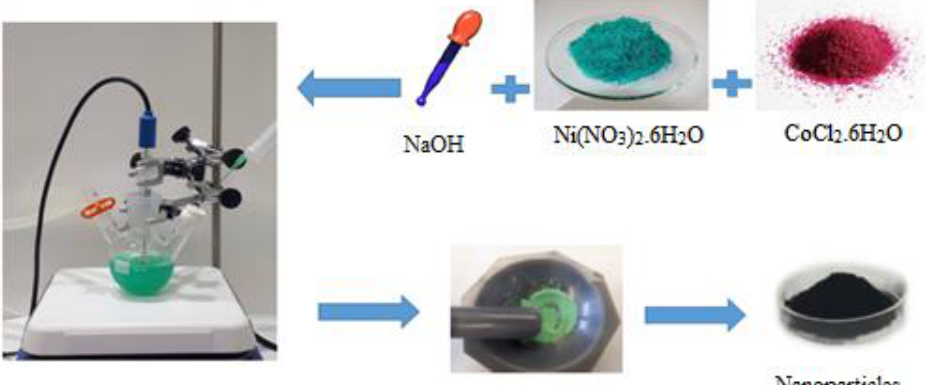
Figure 1. Sketch of the Co-doped NiO x nanoparticles synthesis.